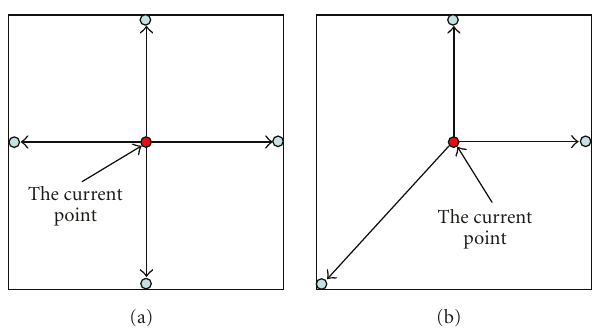
Figure 2: Pattern vectors for the (a) GPS 2 N = 4 positive basis and (b) GPS N + 1 = 3 positive